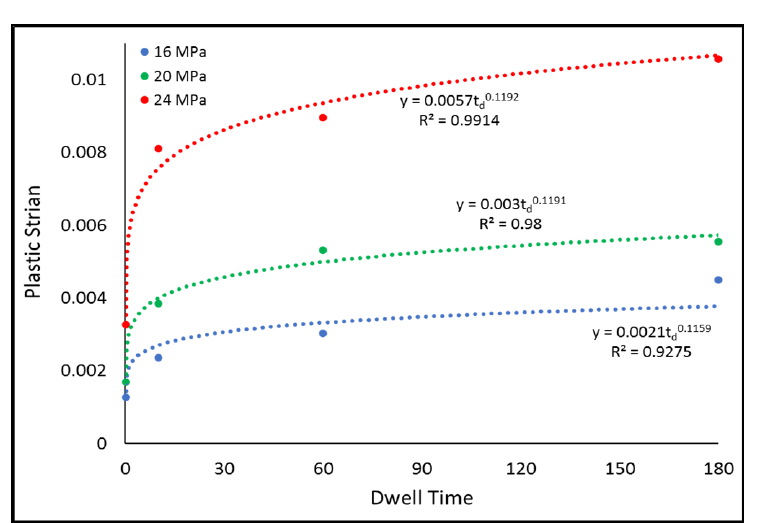
Figure 26. Plastic strain per cycle as a function of dwelling time curves at various stress levels.